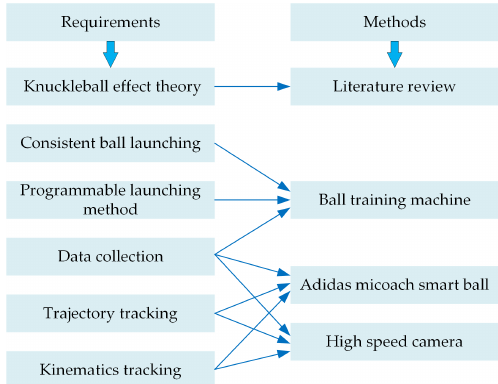
Figure 1. Research requirements and